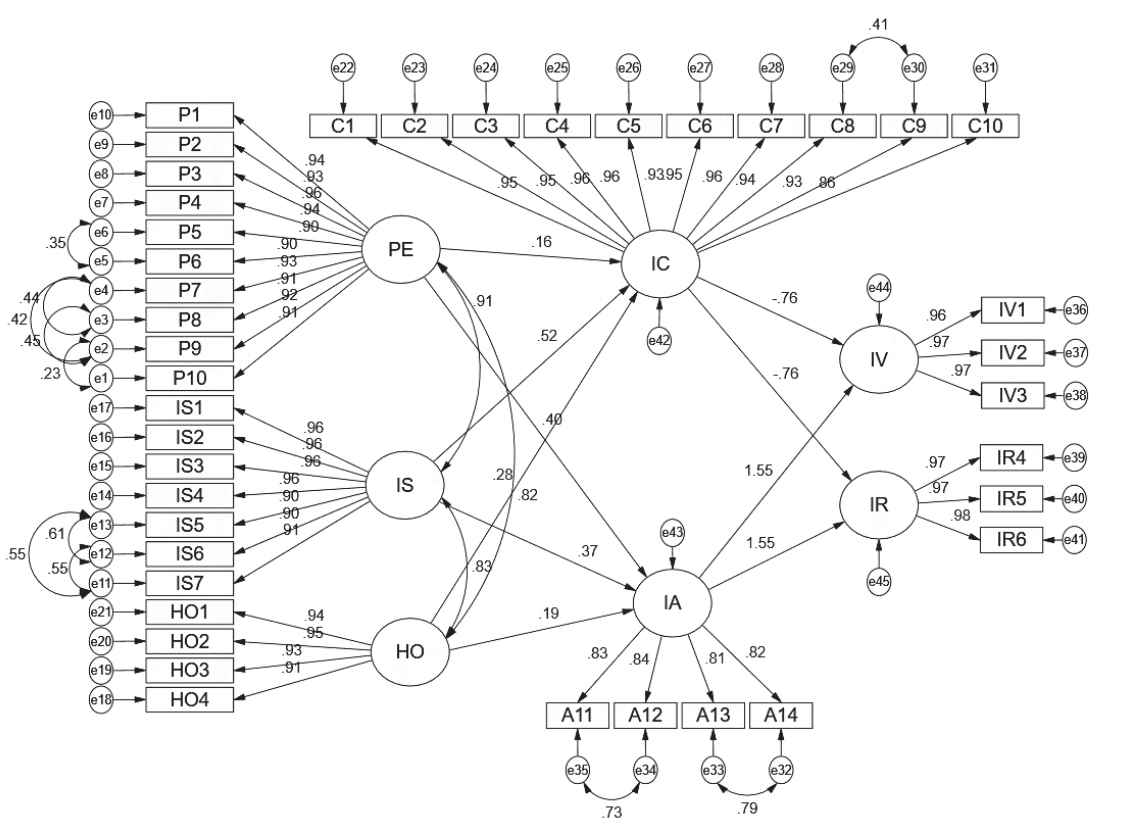
Figure 2. Confirmatory research